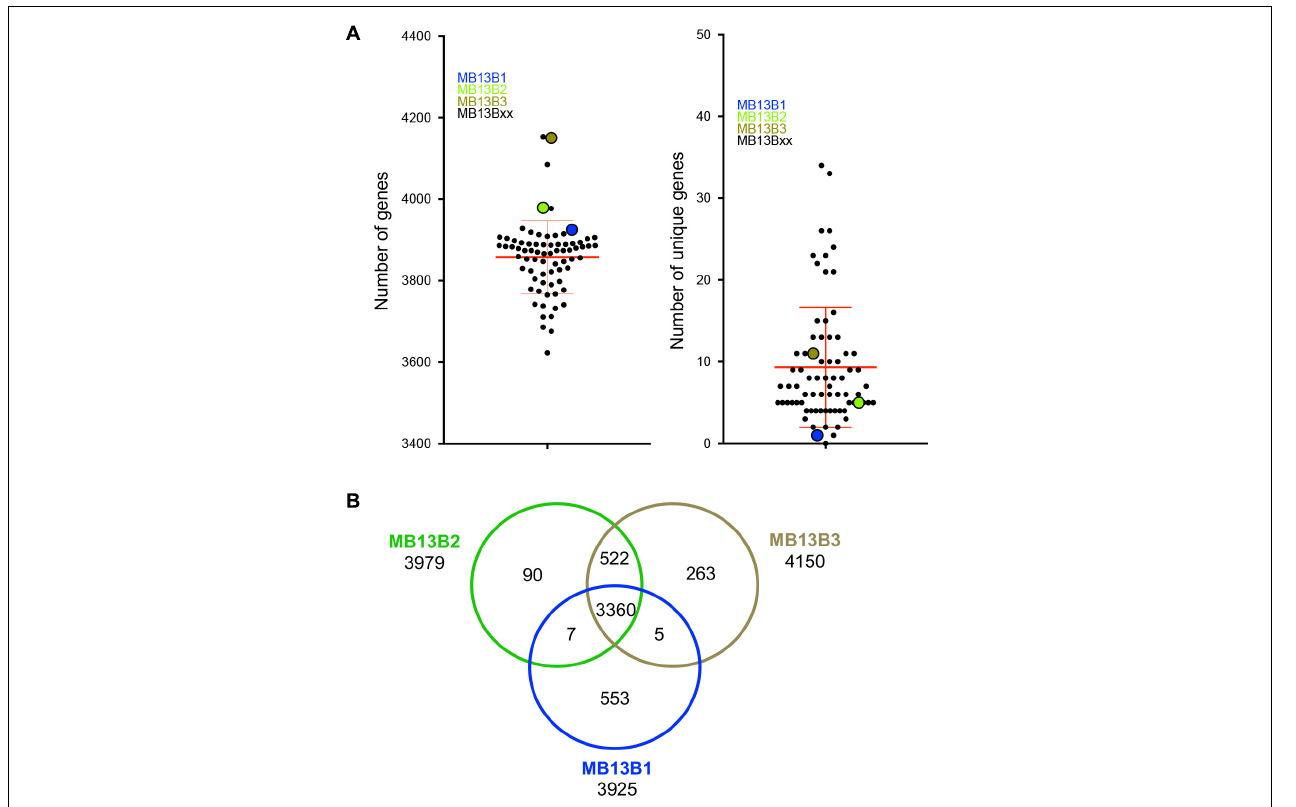
FIGURE 3 | (A) Total number of genes (left) and number of unique genes (right) for each MB13B isolate compared to all other 74 isolates. (B) Venn diagram indicating the number of total, shared and unique genes in a comparison between strains MB13B1, MB13B2 and